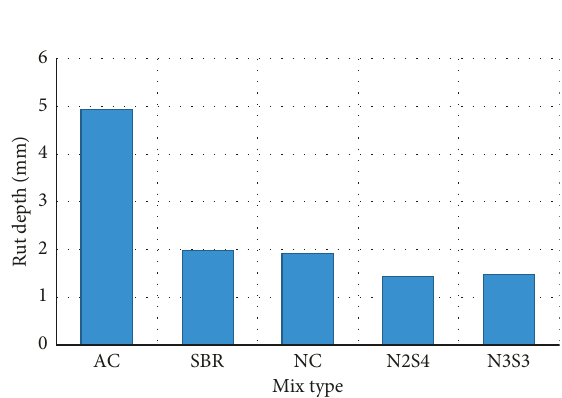
Figure 8: Dynamic creep test.